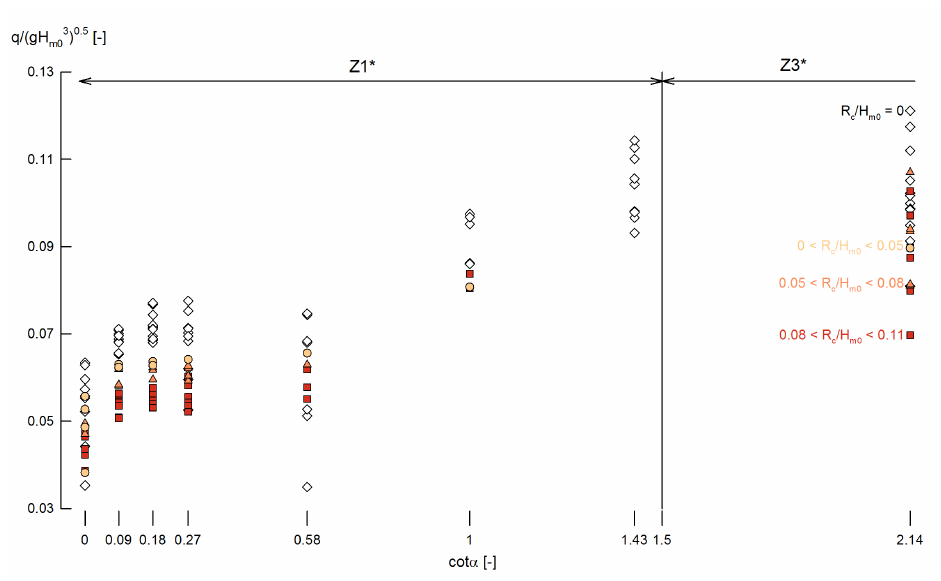
(cid:113) gH 3 as a function of the slope angle (cot α ) m 0